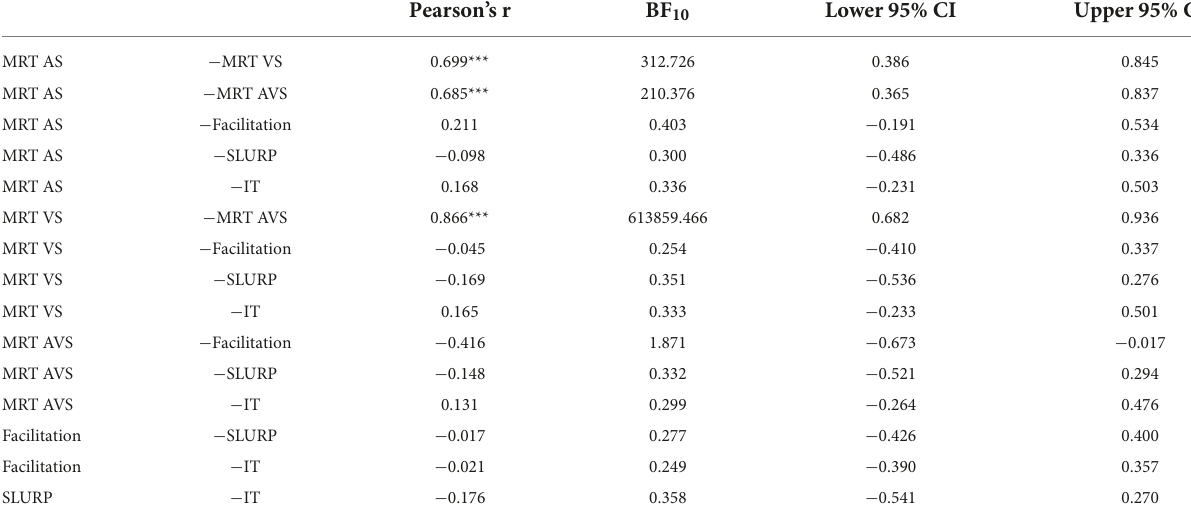
TABLE 5 Bayesian Pearson Correlations, 7 − 8 group.